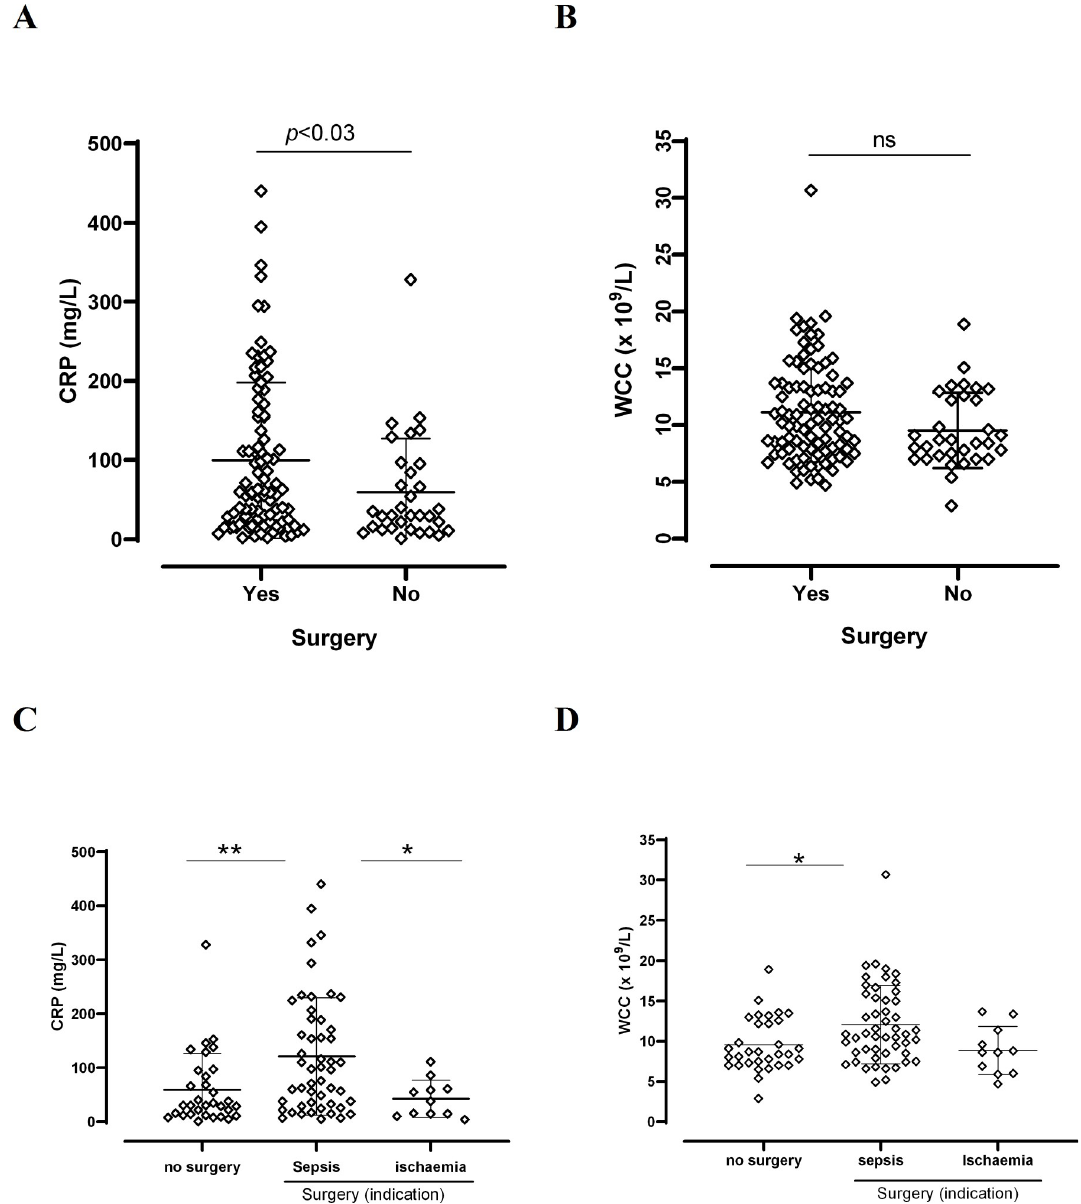
Fig 1. Inflammatory markers in surgical and non-surgical diabetic foot osteomyelitis. A and B : CRP and WCC, respectively, are plotted for patients who had and who did not have surgery. n :“Yes” 91; “No” 32. Unpaired t -test, significant p < 0.05. C and D : CRP and WCC in patients who had no surgery and those who had surgery indicated by sepsis or ischaemia. n : no surgery: 32; surgery sepsis: 50; surgery ischaemia: 11. One-way ANOVA C: p < 0.002; D: p < 0.01. Tukey’s Multiple Comparison test: C: �� : p < 0.009; � : p < 0.03; D: � : p <